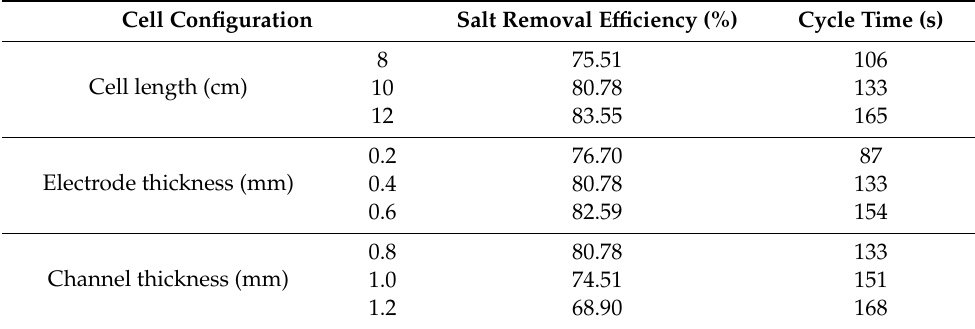
Table 5. E ff ects of cell length, electrode thickness, and channel thickness on the maximum salt removal e ffi ciency and the corresponding cycle time of